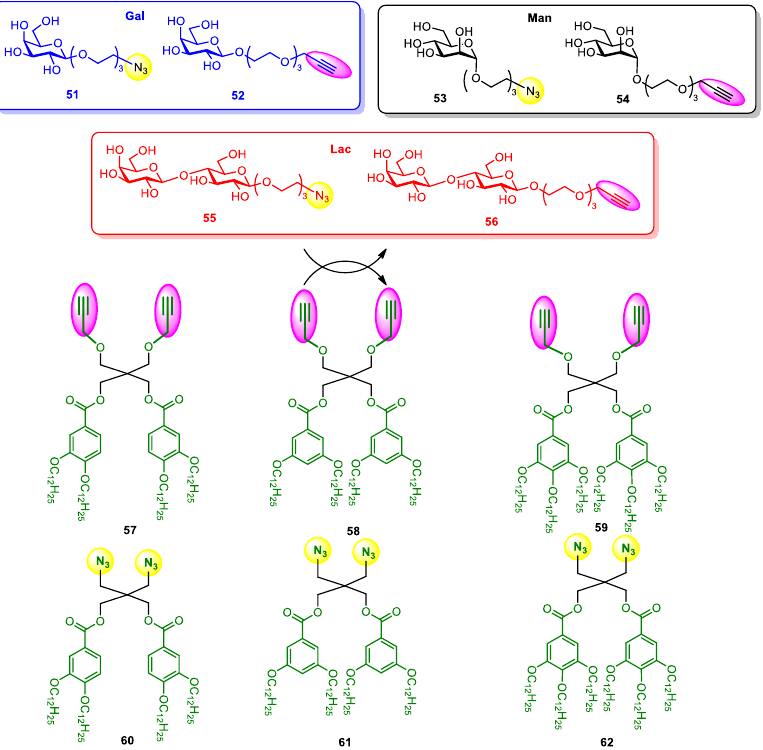
Figure 3. Synthetic strategy and necessary fragments used in the modular construction of seven libraries of 51 dendritic neoglycolipids [30 – 32].